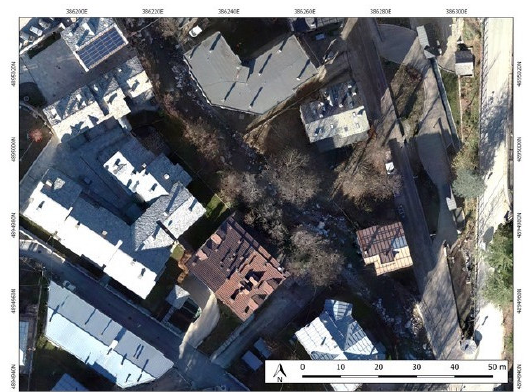
Figure 9. Qualitative comparison between the orthoimages (1:500 map scale) generated adopting Strategy 1 (above) and Strategy 2